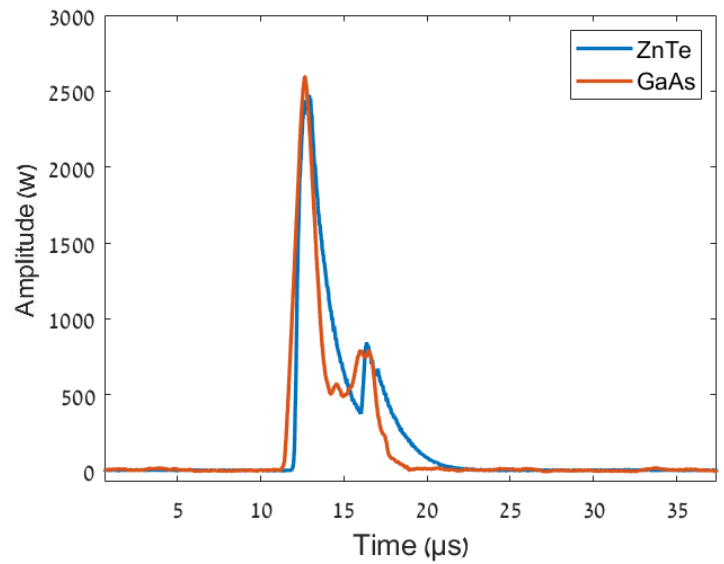
Figure 6. High-power THz pulse detection by electro-optic sampling using GaAs and